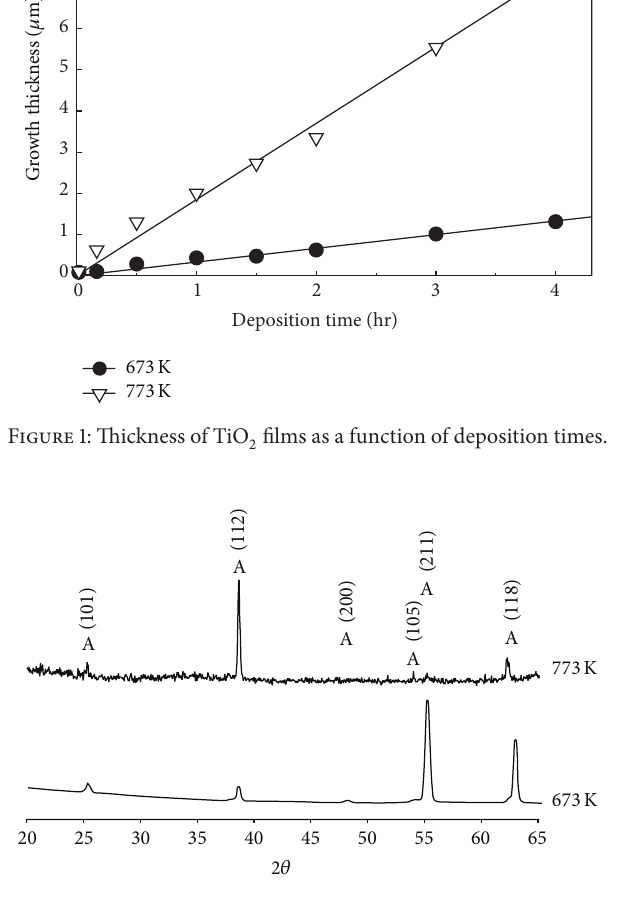
Figure 2: X-ray diffraction of anatase TiO 2 films prepared by CVD method under different deposition